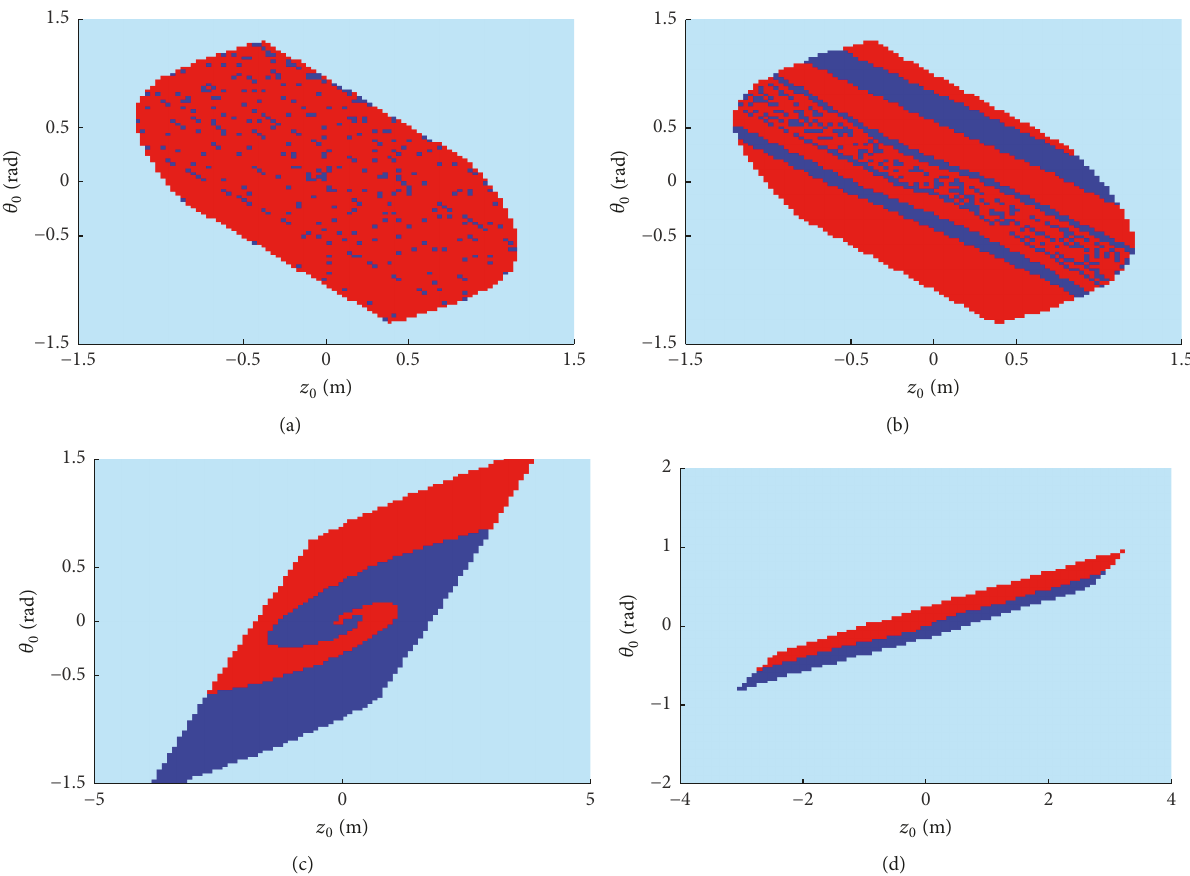
Figure 10: Basins of attraction (a) 𝜎 = 0.03171 , 𝑘 = −71.43 ; (b) 𝜎 = 0.03187 , 𝑘 = −70.94 ; (c) 𝜎 = 0.02805 , 𝑘 = 6.961 ; (d) 𝜎 = 0.02464 , 𝑘 = 9.011